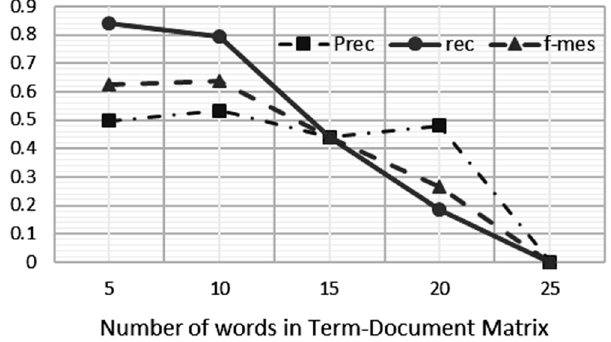
Figure 8. Precision, recall and F-measure results over various term–document matrix definitions.